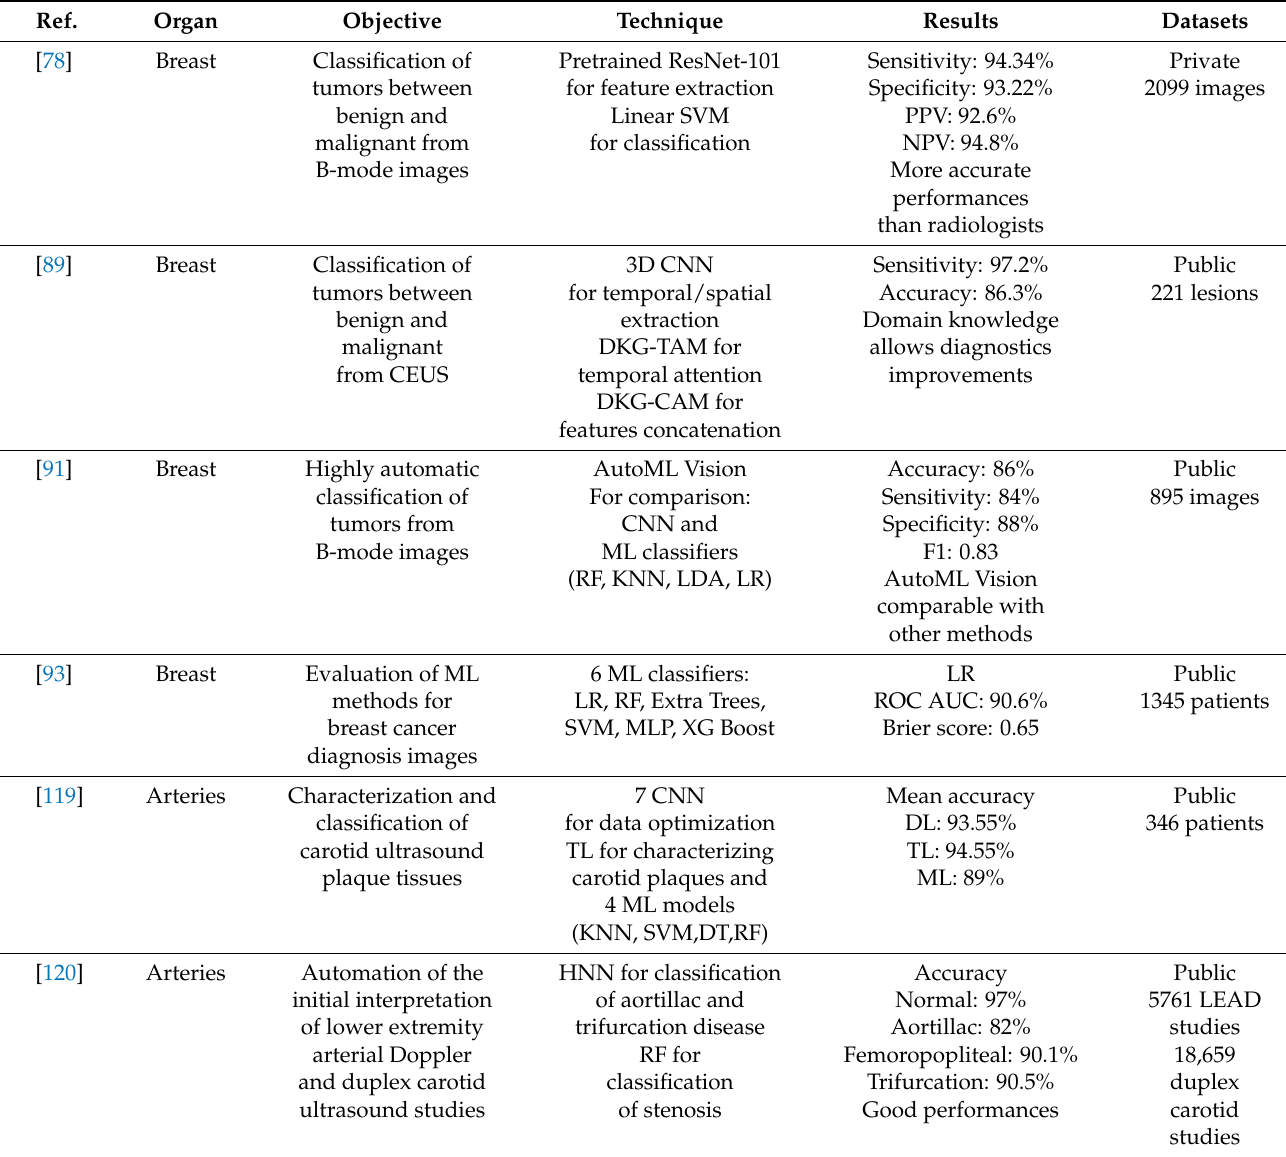
Table 3. Summary of classification ML algorithms employed in studies analyzed related to organ investigated, diagnosis objective, dataset used, and main results achieved.